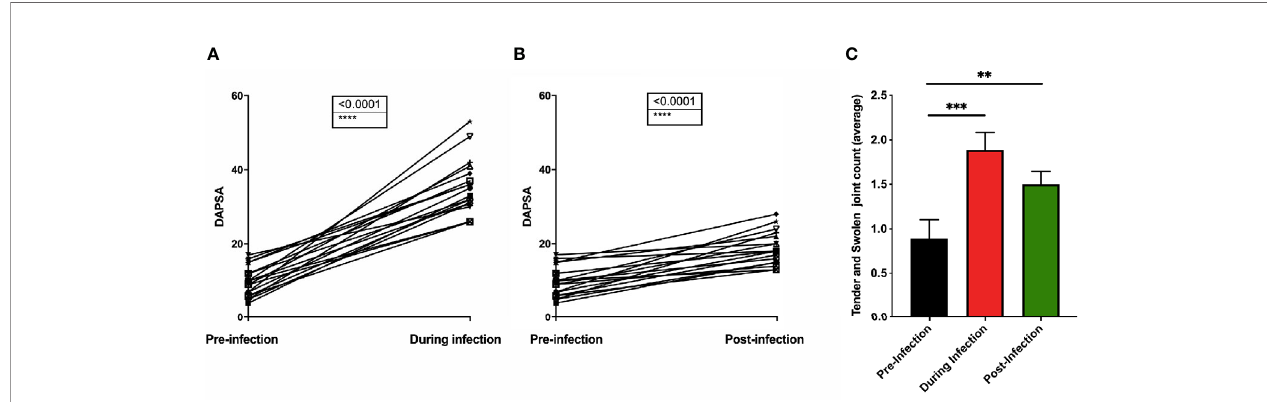
FIGURE 3 | Psoriatic Arthritis patients had DAPSA score calculated both pre-COVID-19 infection and during infection (A) and post-infection (B) . The tender and swollen joint was scored, and the average calculated for pre-infection, during infection and post-infection (C) . n=18. ** p < 0.01, *** p < 0.001 and p